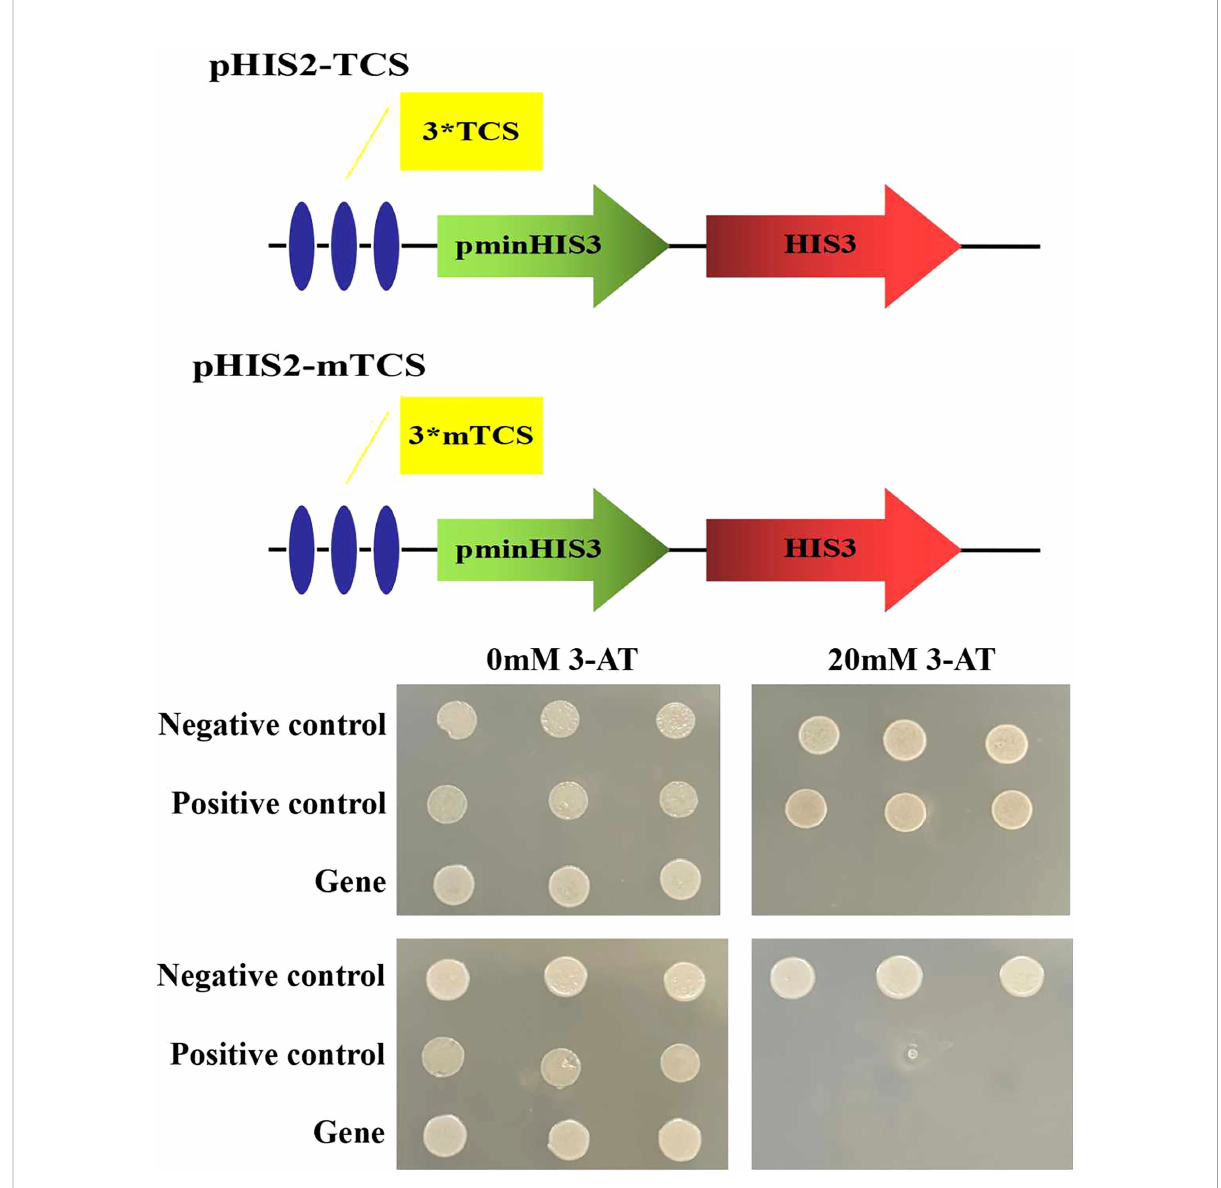
FIGURE 4 DNA-binding assays of ZmLBD2 in Y1HGold yeast cells. Yeast cells were assayed on SD/Trp-/Leu-/His- medium; Negative control: p53HIS2+p GAD-ZmLBD2; Positive control: p53HIS2+pGAD-Rec2-53p53; Gene: different positive colonies; TCS: GCGGCG; mTCS: GAGGAG; 3*: The sequence was repeated three times; 3-AT: